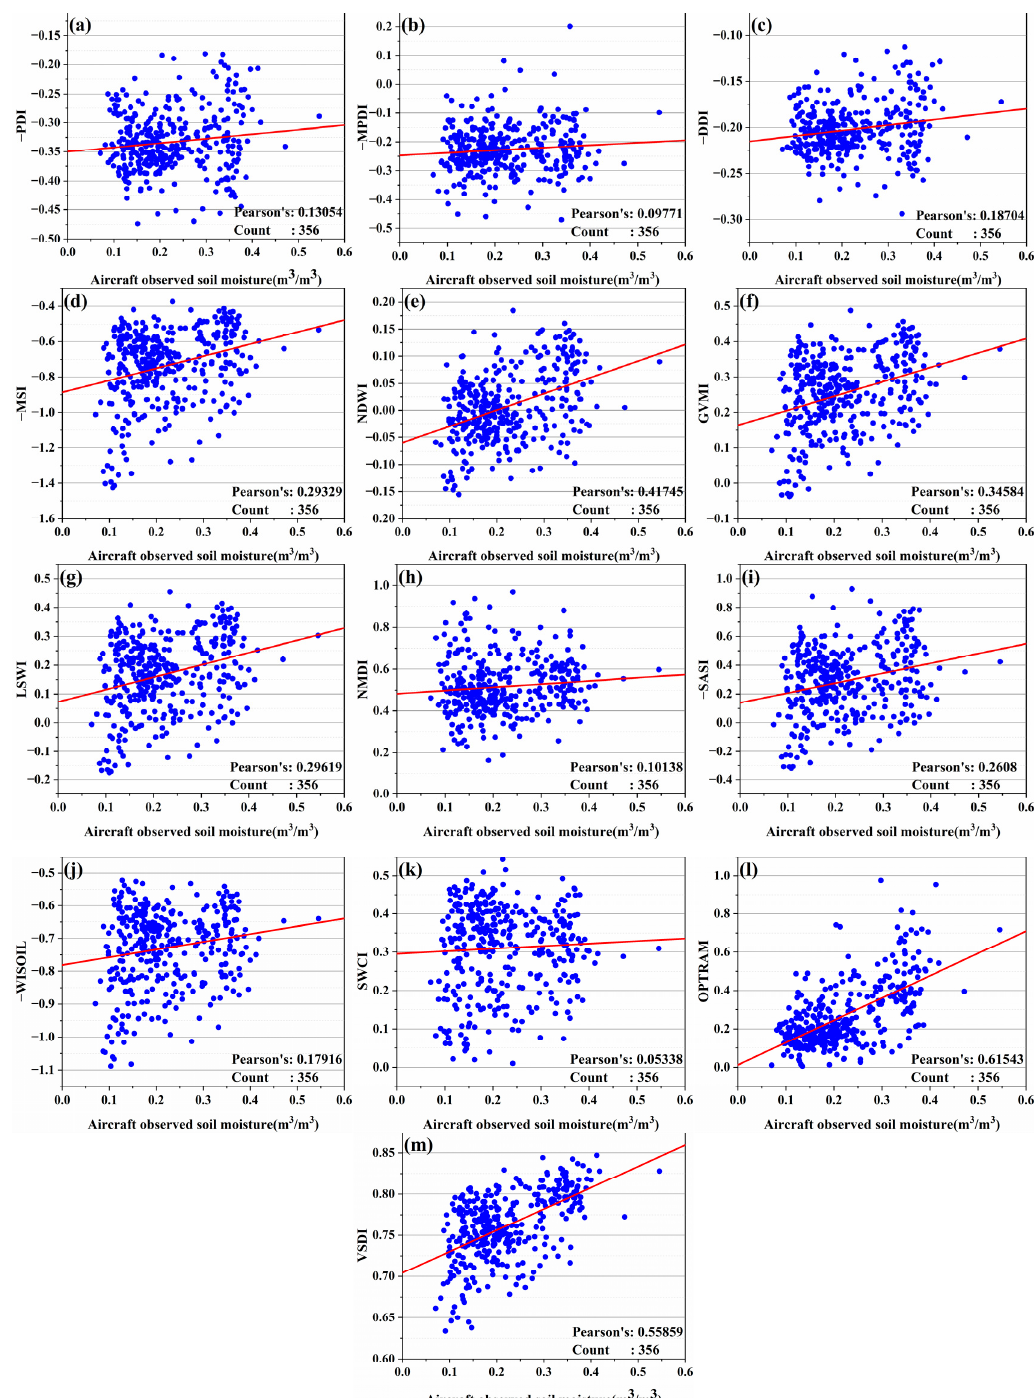
Figure 3. Scatter plots between the aircraft SM and the optical SM indexes during the SMAPVEX12 on 15 June 2012 where ( a ) PDI, ( b ) MPDI, ( c ) DDI, ( d ) MSI, ( e ) NDWI, ( f ) GVMI, ( g ) LSWI, ( h ) NMDI, ( i ) SASI, ( j ) WISOIL, ( k ) SWCI, ( l ) OPTRAM, and ( m ) VSDI.